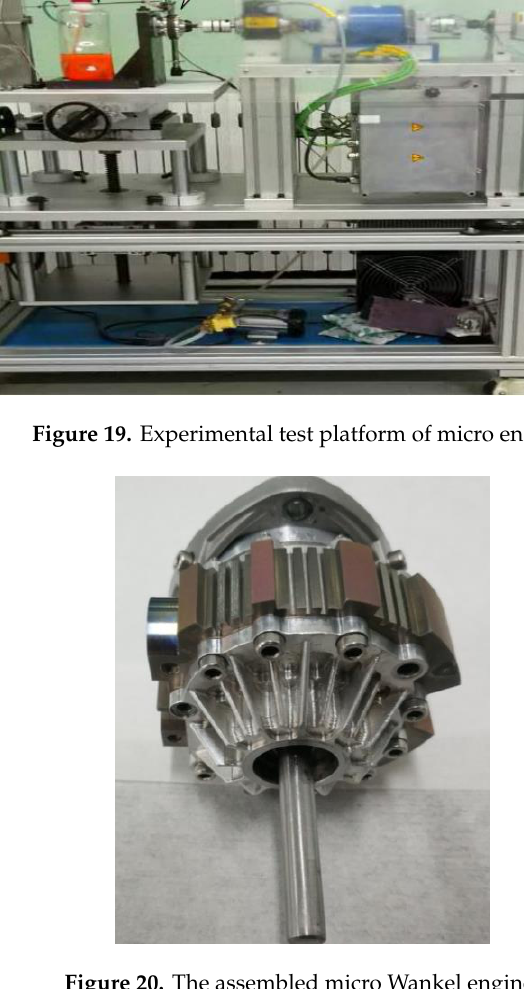
Figure 19. Experimental test platform of micro engine.